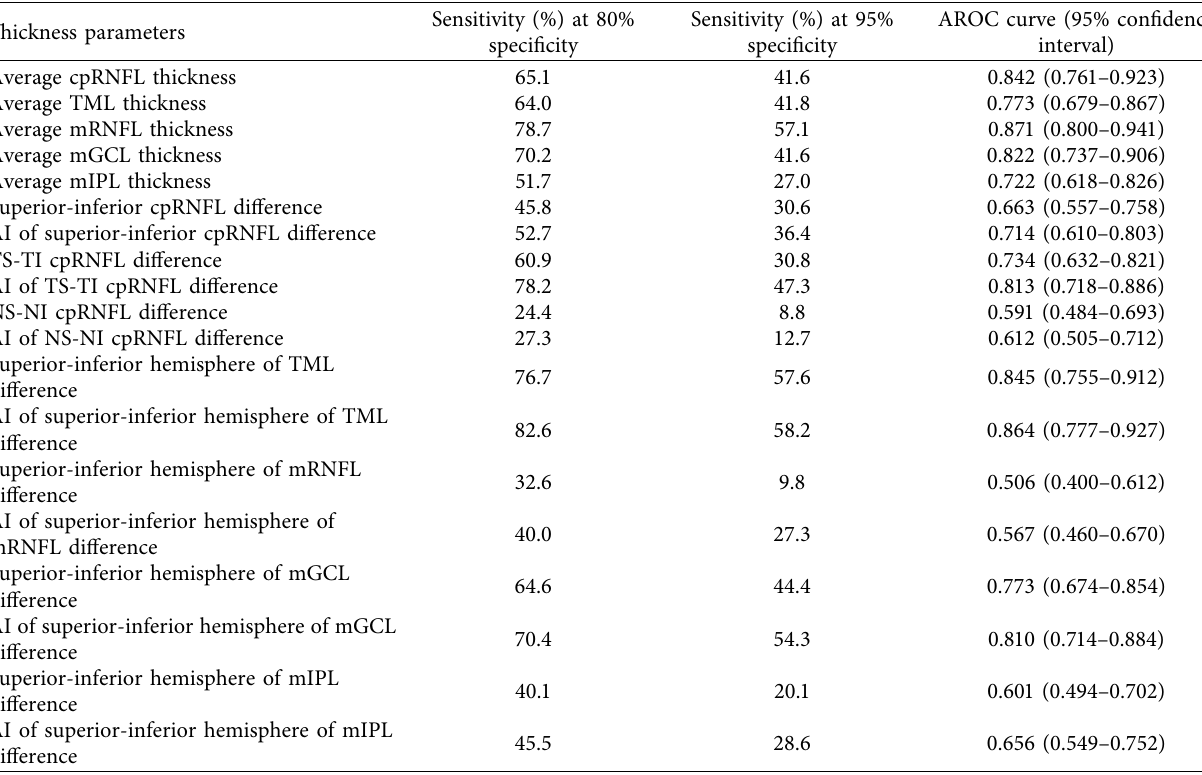
Table 3: Diagnostic capabilities for thickness parameters of circumpapillary retinal nerve fiber layer and macular layers, and diagnostic capabilities for hemisphere differences of circumpapillary retinal nerve fiber layer thickness parameters and macular thickness parameters for differentiating highly myopic normal-tension glaucoma from highly myopic control